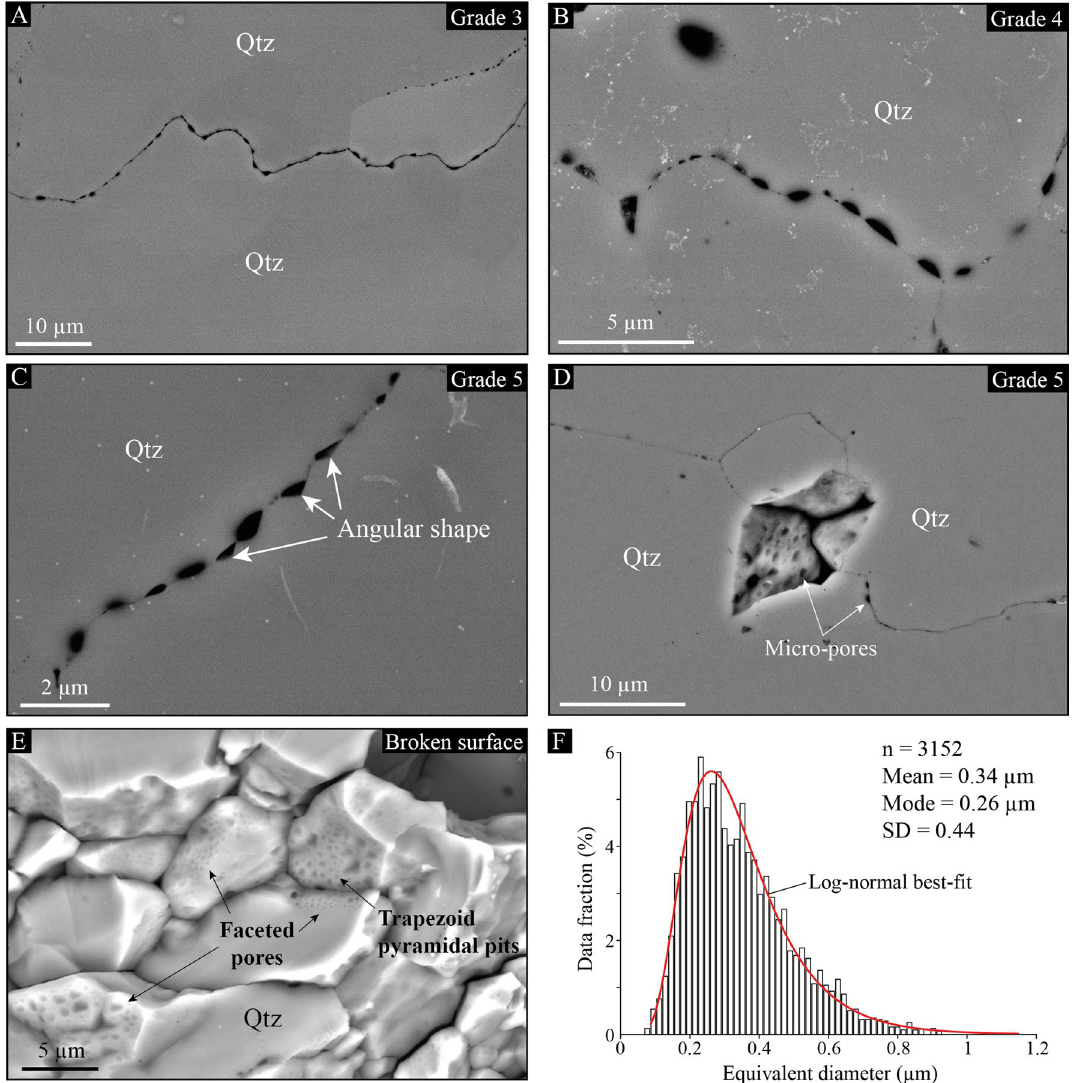
Figure 3. Micro-porosity in quartz-rich shear bands. ( A–C ) Backscattered electron (BSE) images locating representative areas where micro-pores have been observed at grain boundaries of grades 3, 4 and 5. These observations include cordons of pores along lobate boundaries ( A ) with gradual sizes along the boundary ( B ) and/or partly angular shapes ( C ; white arrows). ( D,E ) BSE images of micro-pores highlighted in three dimensions either through a polished surface at the favor of a detached grain during sample preparation ( D ) or on a broken surface in the YZ structural plane ( E ). ( F ) Distribution of pore sizes (equivalent diameter) as documented using pixel counting on BSE images. n number of pores; SD standard